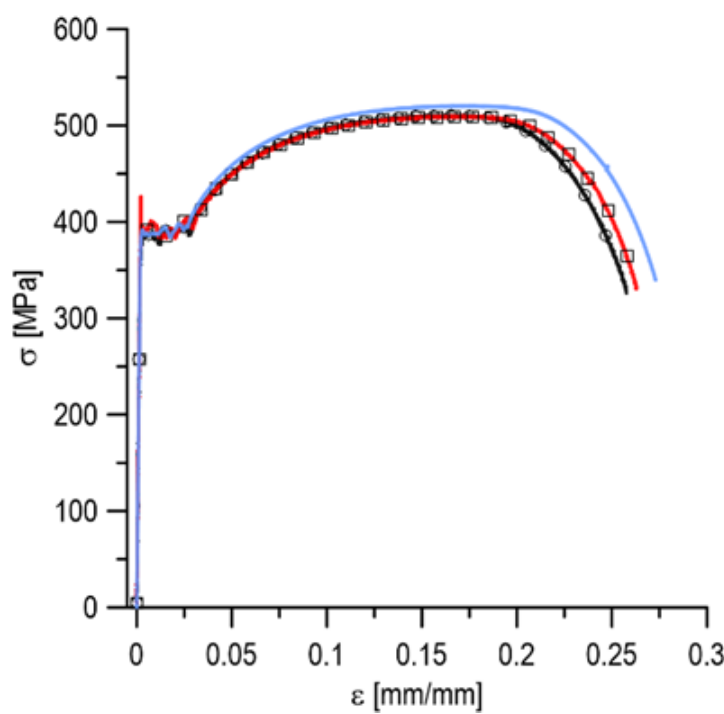
Figure 5. Stress – strain curves for S235 steel (different colors mean three different samples from one series).